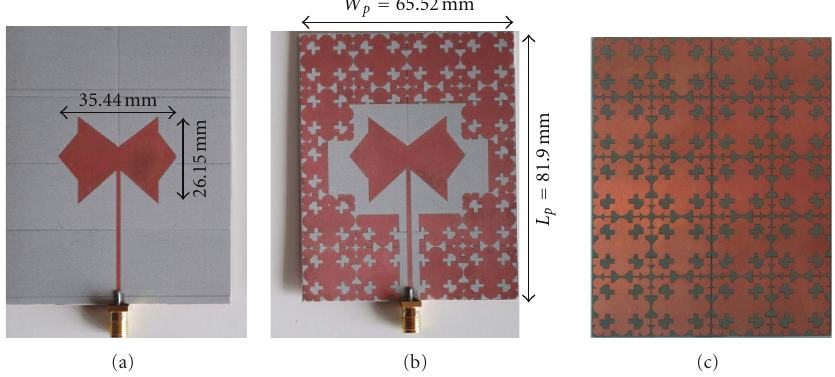
Figure 1: Manufactured prototypes: (a) Patch antenna, (b) Patch antenna-EBG, (c) Planar